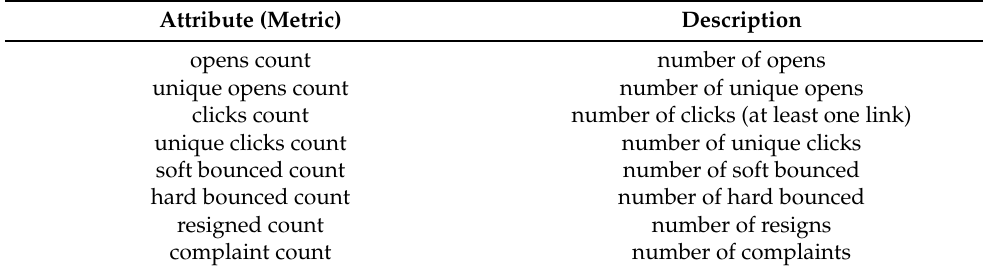
Table 1. Technical attributes (metrics) collected by ESP